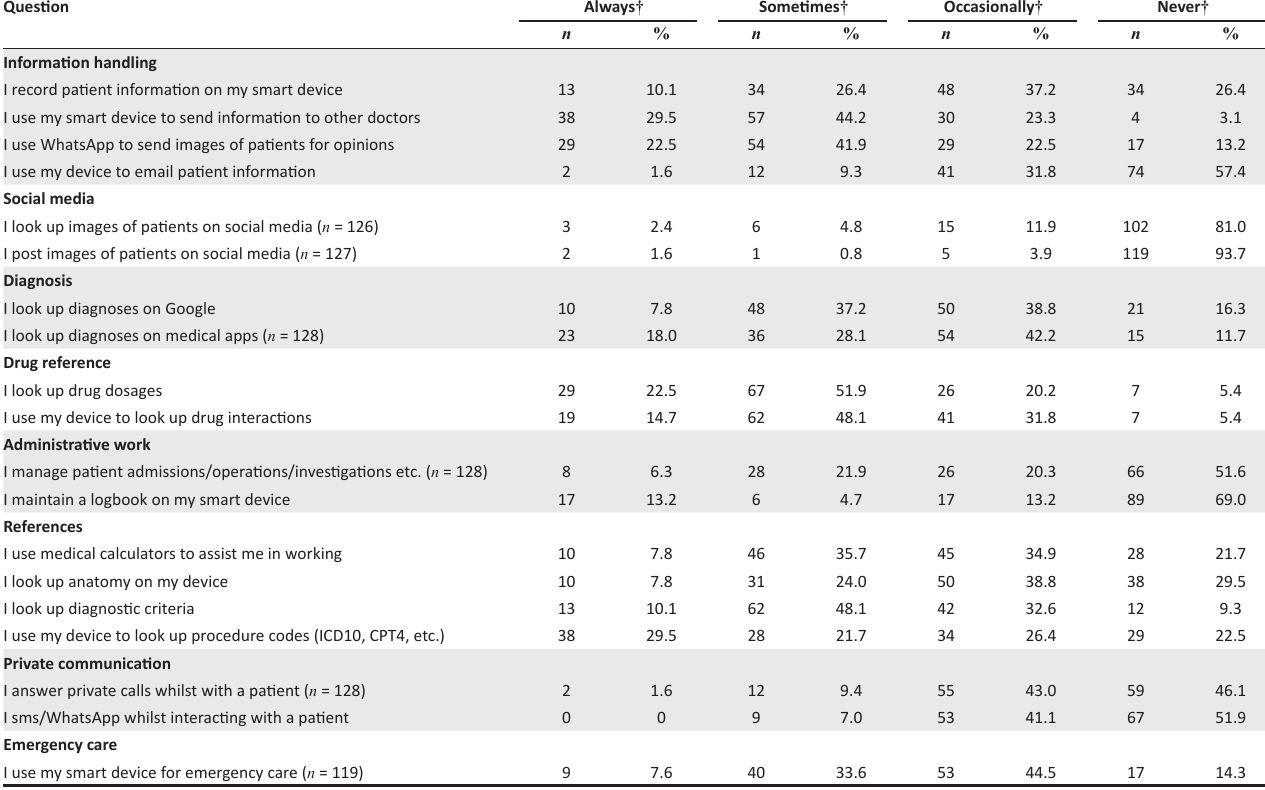
TABLE 3: Frequency of work-related activities performed on their smart devices. Question Always